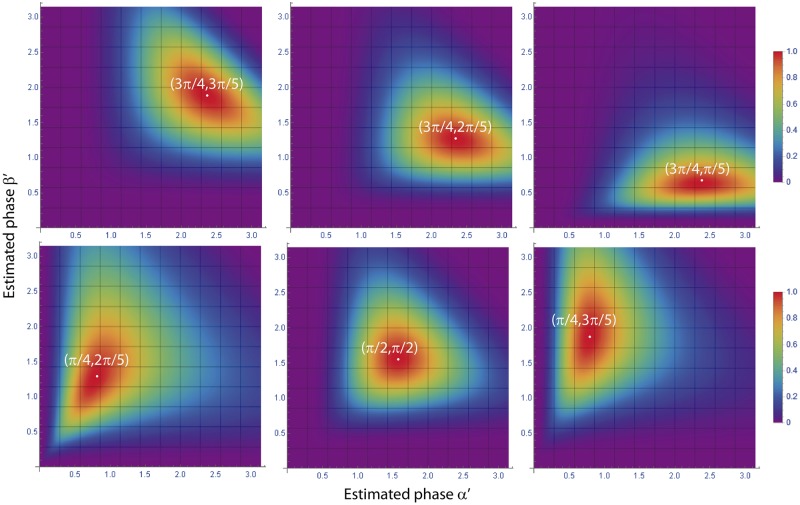
Analytical normalized peak intensity difference surfaces.Theoretical surfaces ϵ(α′, β′) for different real phase-shifts α and β. The marked points represent the maximum of the surface, which coincides with the estimation of the phase-shifts.